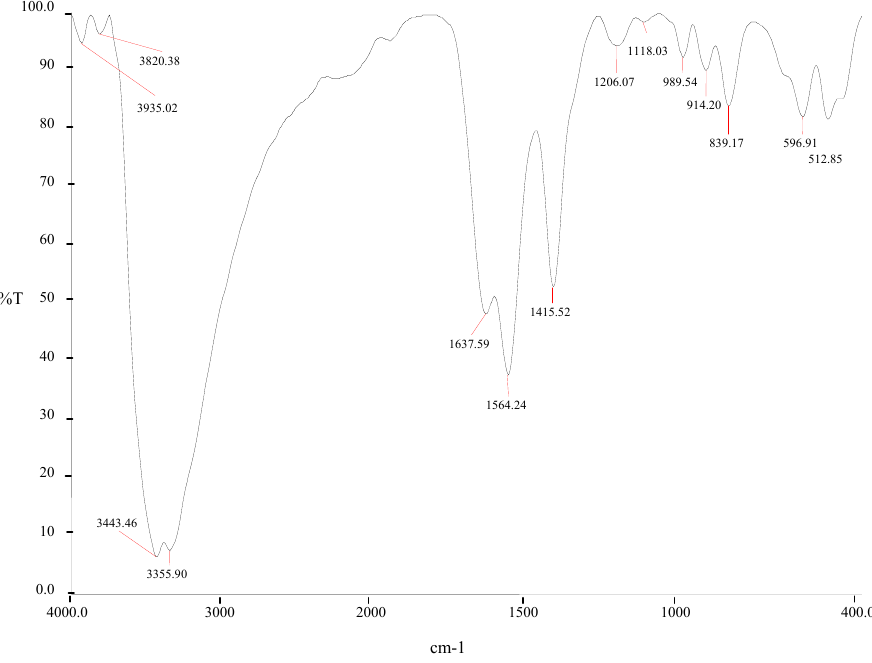
Figure 5. The IR spectrum of acetylation